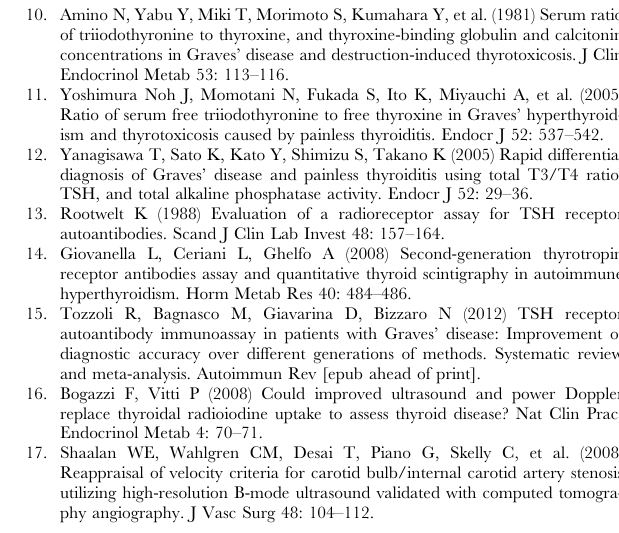
Figure S1 Ultrasound image of subjects with euthyroidism. Figure S2 Ultrasound image of subjects with Graves’ disease. Figure S3 Ultrasound image of subjects with subacute thyroid-